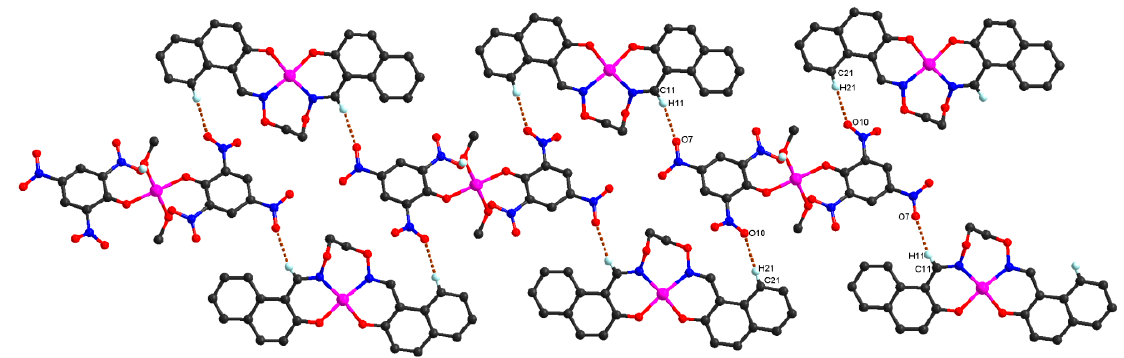
Figure 6. Part of intermolecular C-H···O hydrogen-bonding interactions in 1 . Table 5. Putative π - π stacking interactions [Å] for complex 1 .